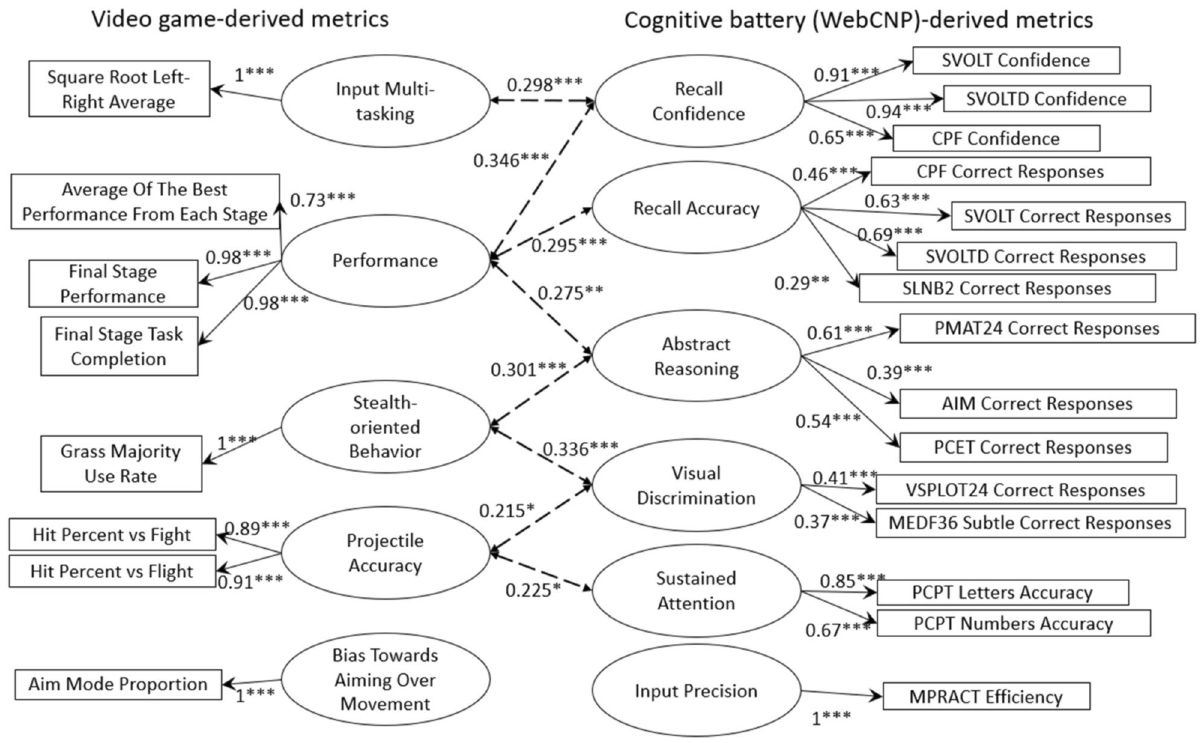
Figure 1. Diagram depicting the individual components used in computing latent variable metrics from video-game-based metrics (left side) and cognitive battery-based metrics (right side). All path coefficients were significant (*p < 0.05, **p < 0.01, ***p < 0.001). Standardized path coefficients shown such that the latent variable’s variance is 1.00. Dashed lines in the center between latent factors depict significant correlations (Pearson’s r ) between video-game-derived metrics and cognitive-battery-derived metrics among those in the younger group of participants (N = 100). Older group (N = 54) correlations did not meet the significance threshold (p < 0.05). Whole-group (N = 154) inter-factor correlations not depicted; see Table 1 for